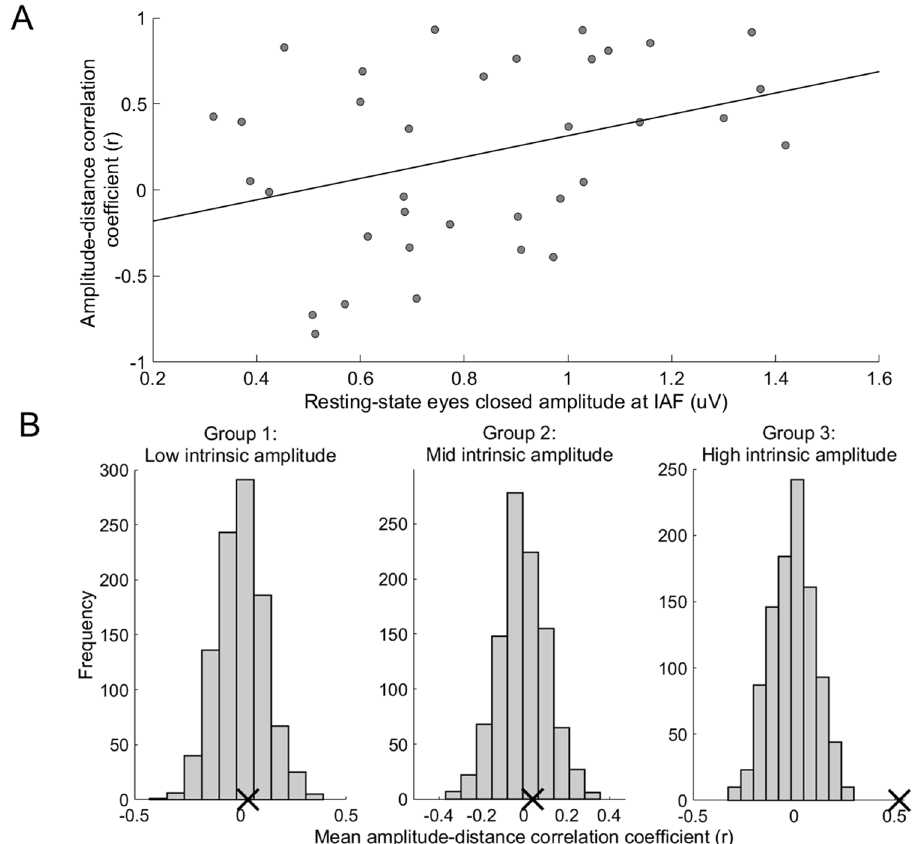
Figure 7. The relationship between the amplitude-distance correlation coefficients of occipitoparietal alpha oscillations and their amplitude at IAF at resting-state eyes closed. (Panel A ). The linear mixed model analysis showed a significant predictive relationship of intrinsic IAF amplitude at resting-state eyes closed on the amplitude-distance correlation coefficient across all components (F(1,33) = 7.214, p = 0.011, slope estimate = 0.714, adjusted R 2 = 0.485). A least squares best fit line is shown. (Panel B ). Histograms of the permuted distribution of mean amplitude-distance correlation coefficients, grouped by intrinsic amplitude. This significant relationship is driven by the relatively higher intrinsically powered oscillators, as shown via three permutation tests. The 35 chosen components were split into three groups based on their amplitude at resting- state eyes closed at the IAF: low (amplitude < 0.62 uV), mid (amplitude between 0.62 and 0.972 uV) and high (amplitude > 0.972 uV). A permutation test was conducted on each group’s components, finding the distribution of the mean amplitude-distance correlation coefficient expected under the null hypothesis, permuted 1000 times. The permutation tests on Group 1 and Group 2 – i.e., components with low and mid resting-state eyes closed amplitude at IAF- showed that our observed mean amplitude-distance correlation coefficient